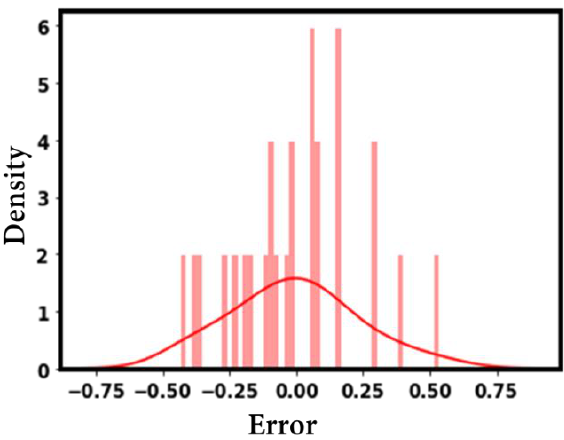
Figure 15. Error density representation.